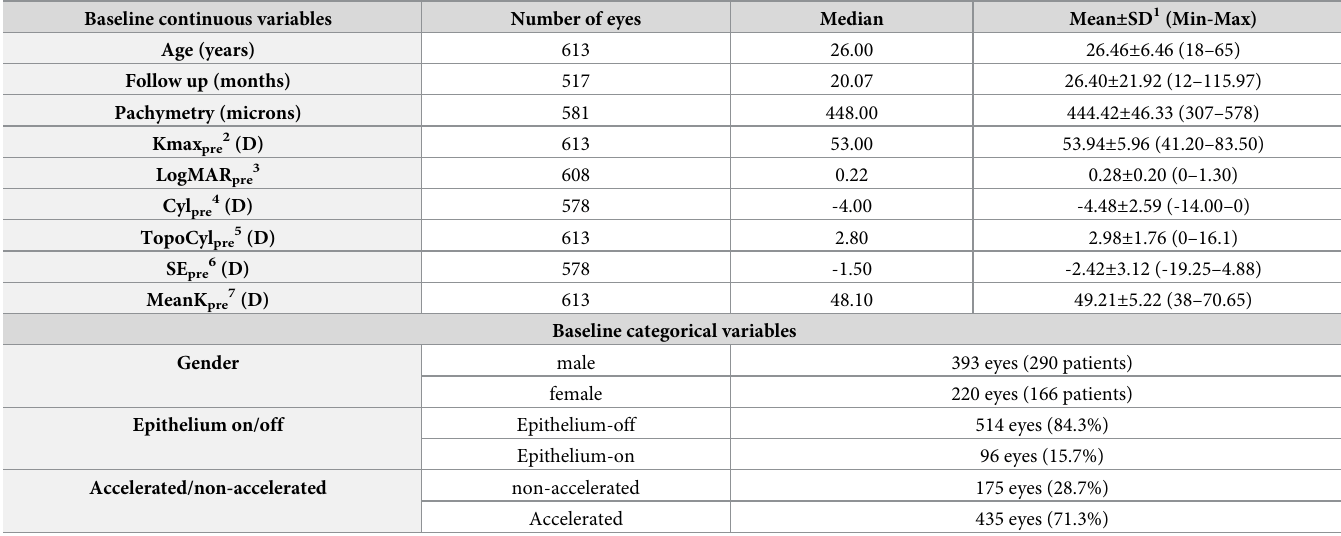
Table 1. Baseline patient’s characteristics.